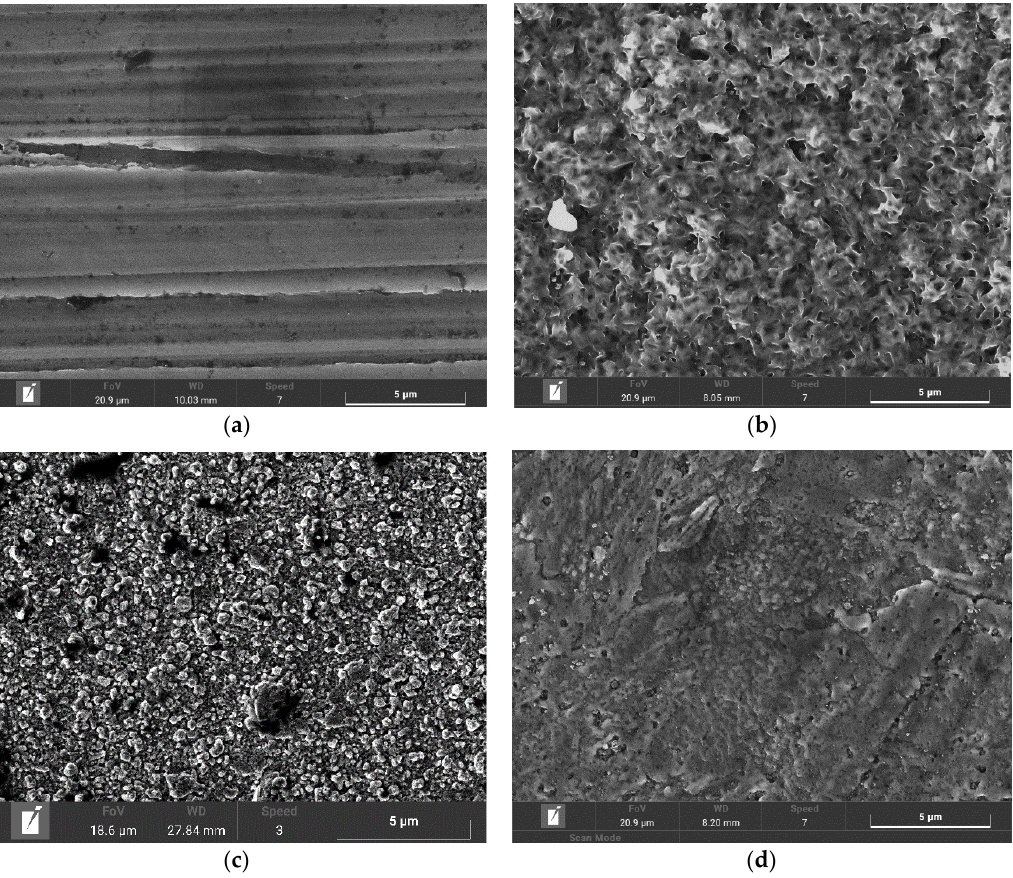
Figure 4. Surface morphology of specimens. ( a ) Heat-treated; ( b ) after 6 h of gaseous FNC; ( c ) after 6 h of plasma FNC; and ( d ) after 4 h of plasma FNC. Magnification, 10,000×.